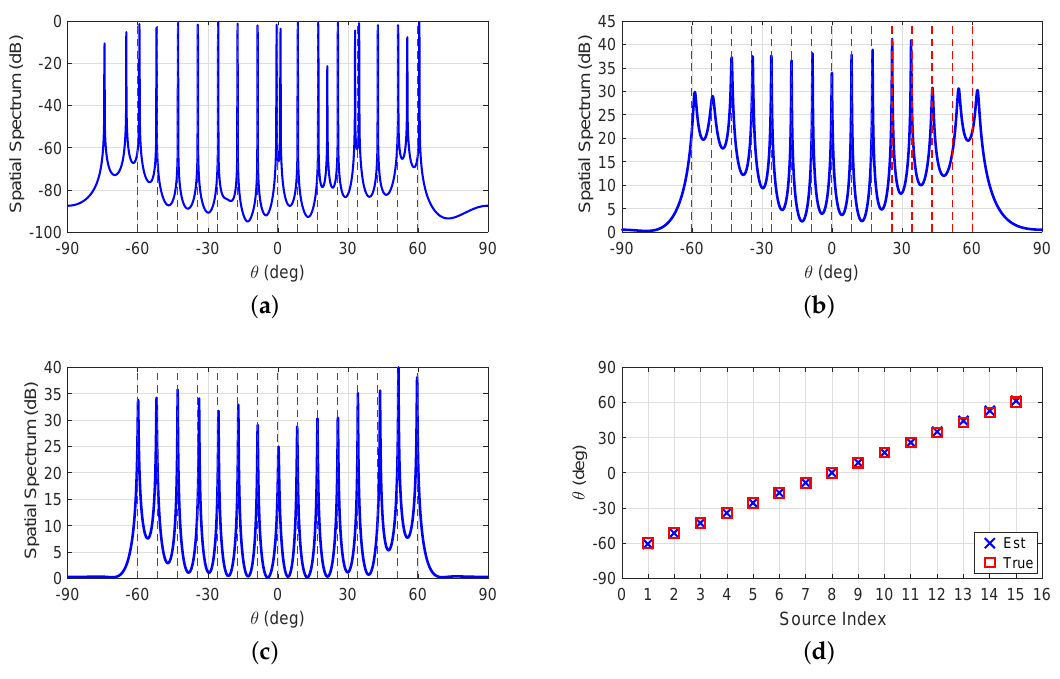
Figure 4. Direction-of-arrival (DOA) estimation performance of each algorithm using coprime array when there are more sources than sensors. ( a ) sparse signal reconstruction (SSR) algorithm; ( b ) spatial smoothing multiple signal classification (SS-MUSIC) algorithm; ( c ) coprime virtual array interpolation-based algorithm; ( d ) proposed